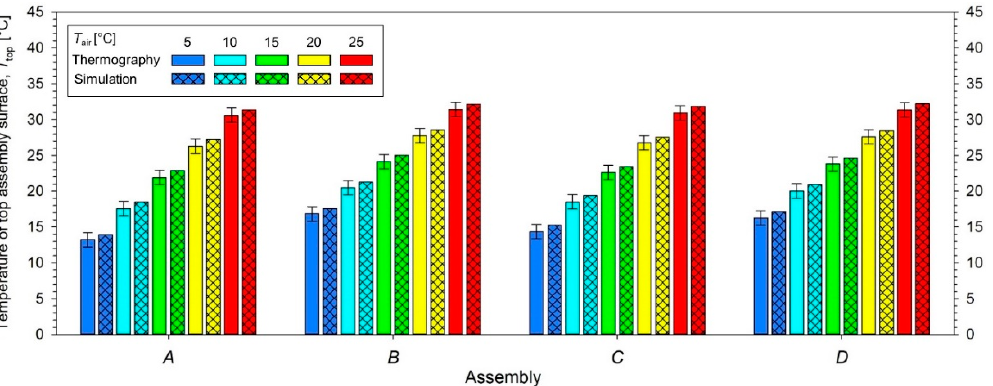
Figure 9. Experimental and simulated temperatures of top assembly surface T top in selected ambient conditions (for the experimental results, the range of measurement error of T top (±1 °C), which is a result of the specification of the thermal imaging camera, has been marked on thermography bars). Table 4. Experimental and simulated temperatures of top assembly surface T top and temperature drops D T.